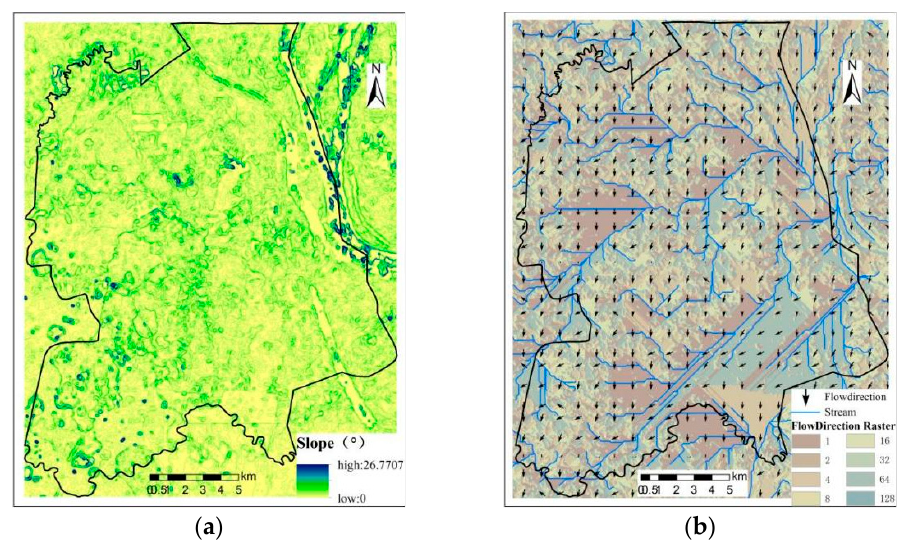
Figure 4. DEM: ( a ) Slope analysis; ( b ) Flow grid.